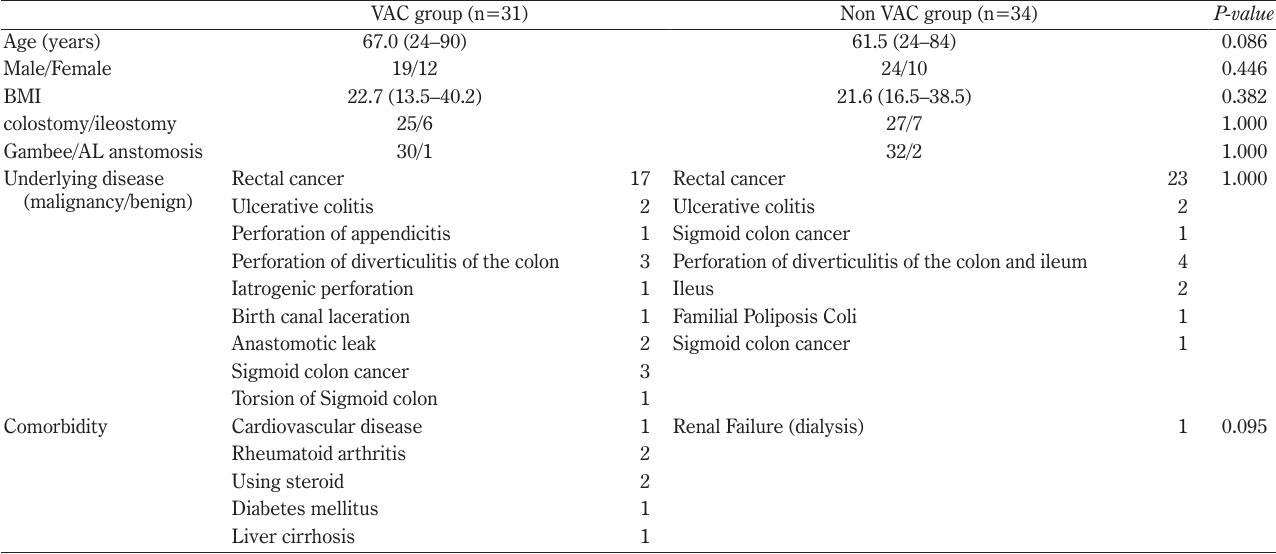
Table 1 Patients’ characteristics